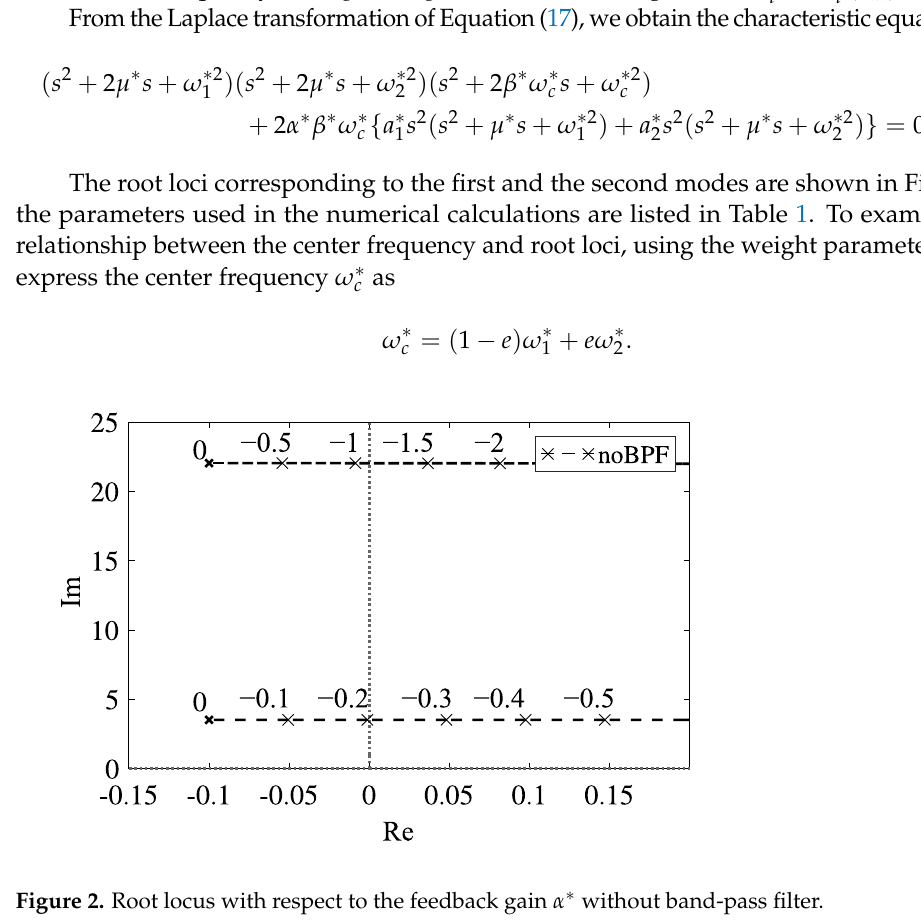
Figure 2. Root locus with respect to the feedback gain α ∗ without band-pass filter. The dashed black lines with the cross marker in Figure 2 represent the root